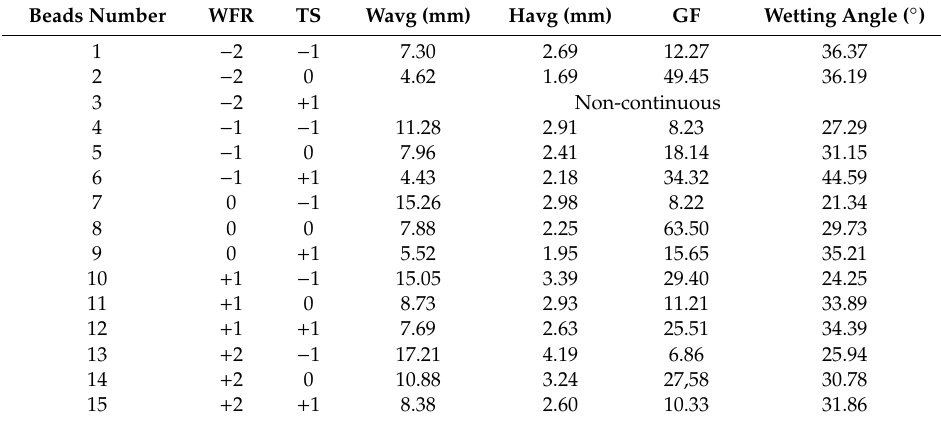
Table 2. Measurement results of the beads’ geometry.